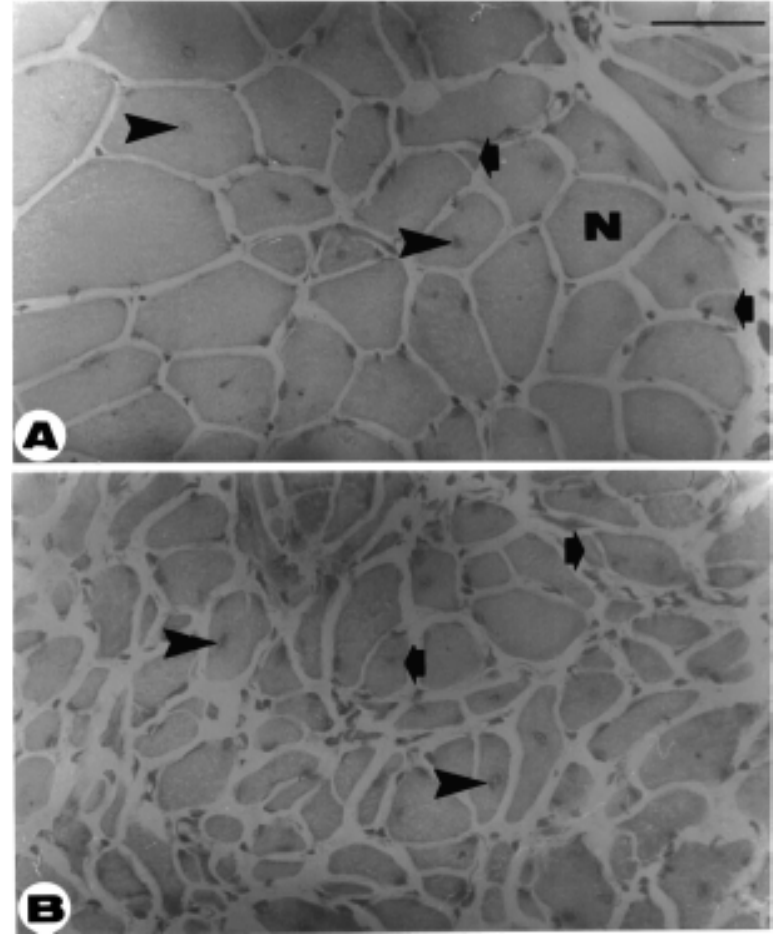
Figure 1. Histological cross-sections of the superficial (A) and deep (B) regions of tibialis anterior muscle, four months after periodic muscle injuries. Signs of regenerated muscle fibers are identified by the presence of centralized nuclei (arrowheads) and split fibers (arrows). Note large spaces among the muscle fibers in the deep region of the muscle (B). Also, the signs of previous muscle injury are more abundant in the deep region of the muscle (B) when compared to the superficial region (A). N = normal fibers. Toluidine blue stain. Bar: 42